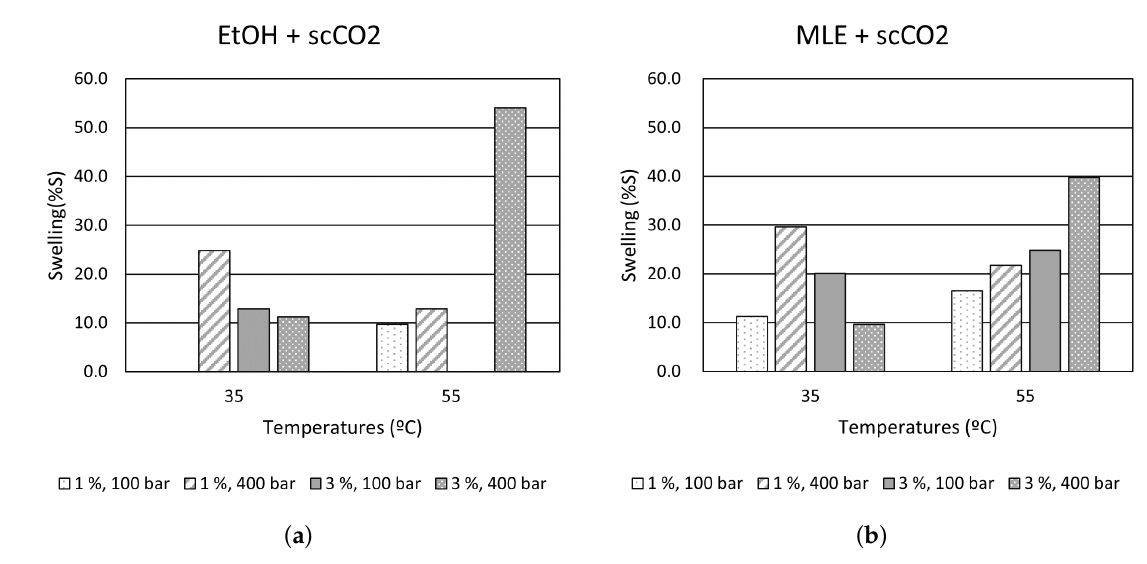
Figure 4. Evolution of swelling under the different impregnation conditions: ( a ) Swelling of the polymer filaments impregnated with just ethanol. ( b ) Swelling of the polymer filaments impregnated with